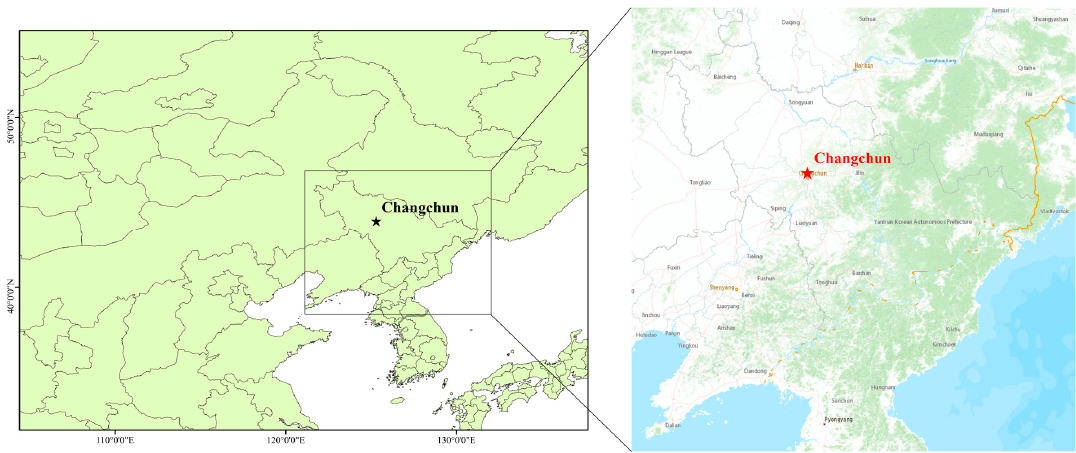
Figure 1. The research location of this study (the star represents the location of Changchun